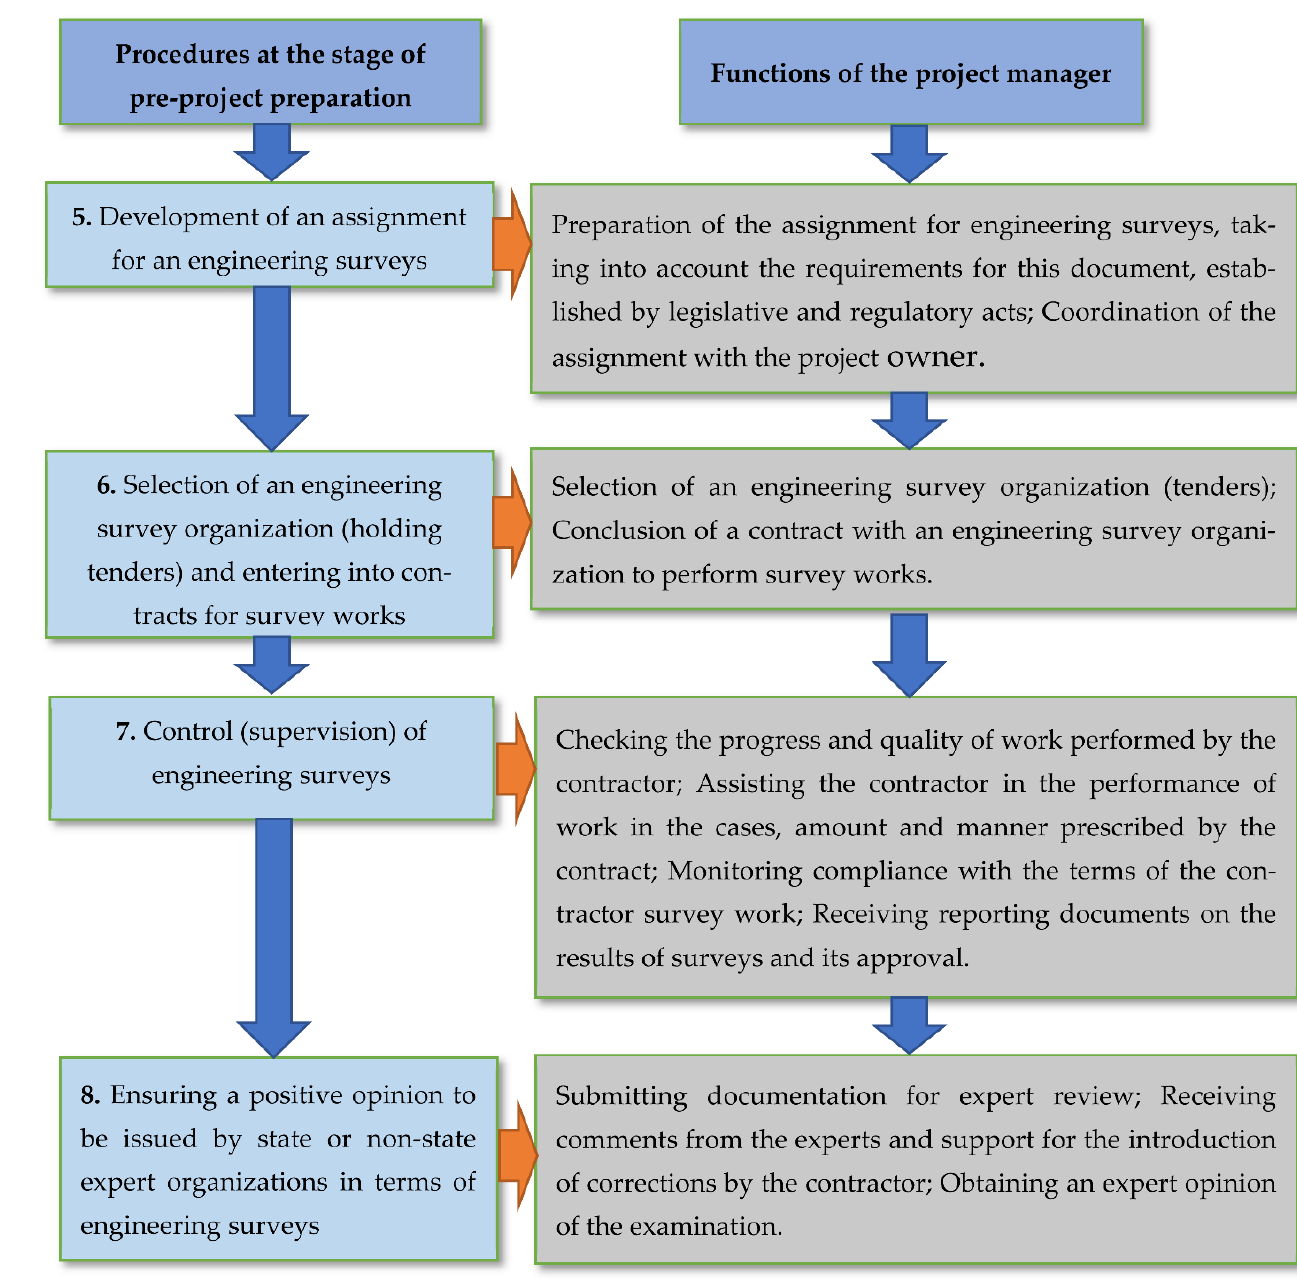
Figure 8. Consolidated procedures and functions of the project manager at the stage of pre-project preparation of a facility for construction. Part two.